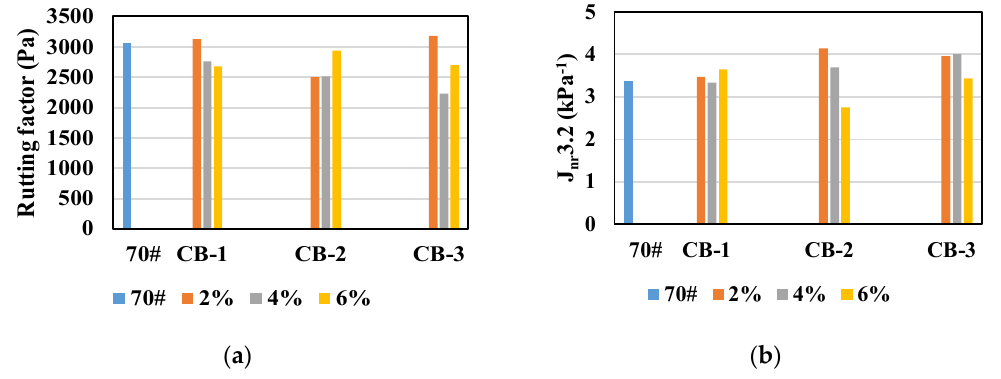
Figure 8. Rutting factors and J nr 3.2 values of asphalt specimens after TFOT aging: ( a ) rutting factor; ( b ) J nr 3.2.